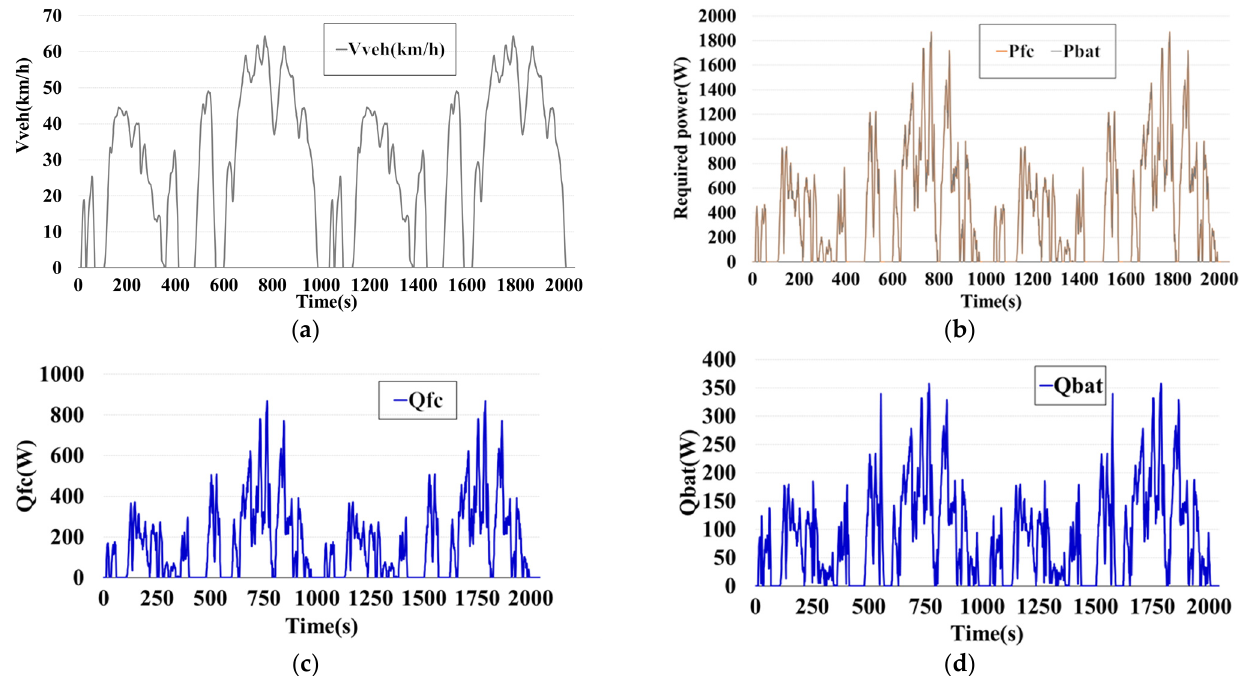
Figure 8. Driving Scenarios with the emulated variables: ( a ) WLTP class 1 driving cycles; ( b ) required power of two energy sources; ( c ) waste heat of emulated PEMFC; ( d ) waste heat of emulated lithium battery.